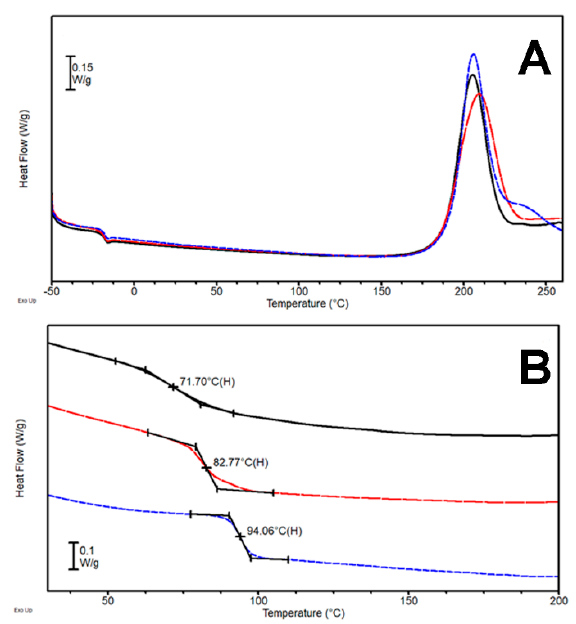
Figure 4. ( A ) DSC first heating scan (heating rate 5 °C/min) and ( B ) second heating scan (heating Figure 5. ( A ) DSC first heating scan (heating rate 5 ◦ C/min) and ( B ) second heating scan (heating rate 20 °C/min) for the systems DTC-1 (—), DTC-2.5 (---), and DTC-5 (---). rate 20 ◦ C/min) for the systems DTC-1 (—), DTC-2.5 (—), and DTC-5